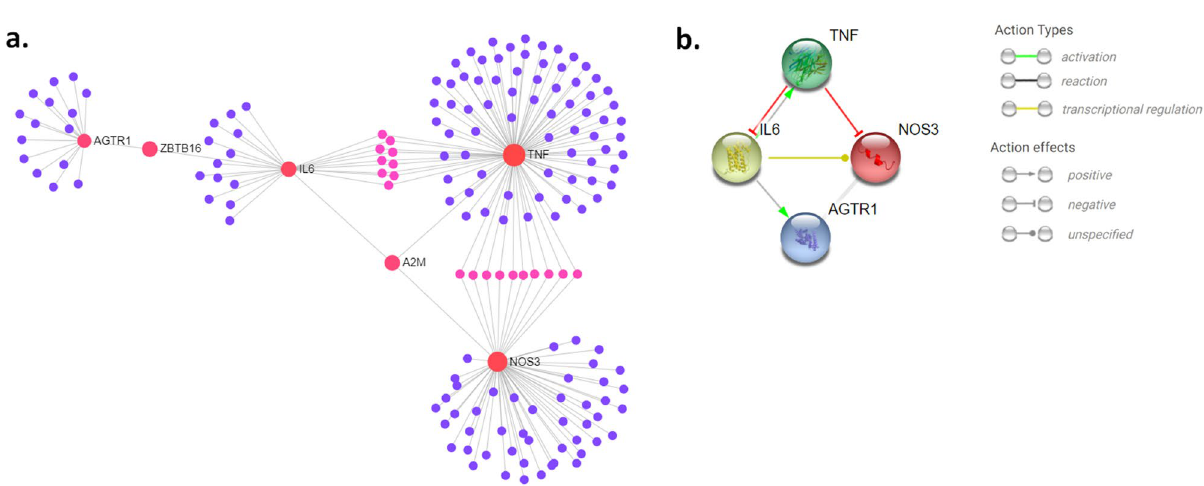
Figure 1. Protein–protein interaction networks. (A) Network derived from IMEx interactome database (using NetworkAnalyst 120 web-based visual analytics platform) shows interactions among AGTR1, IL6, NOS3 and TNFA. (B) Network derived through STRING database 30 shows the nature of interactions among AGTR1, IL6, NOS3 and